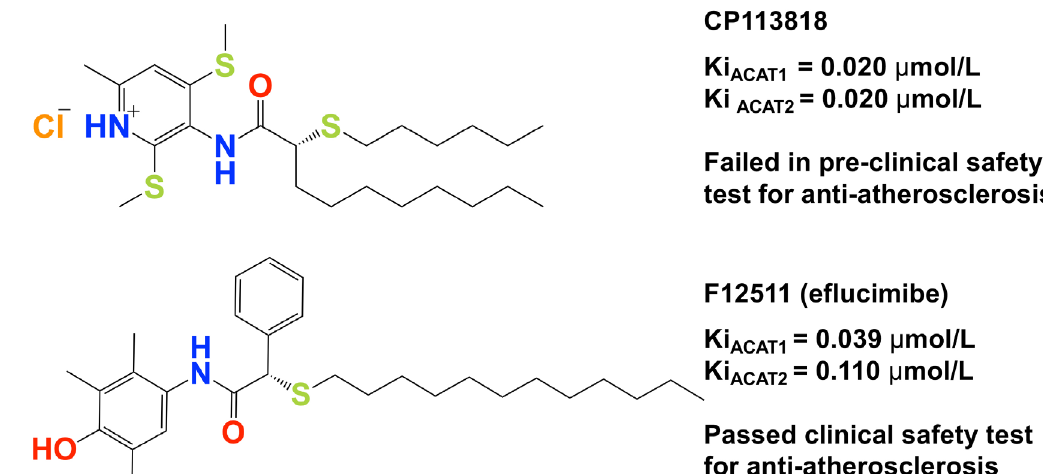
Figure 3. Comparison of 2 high-affinity ACAT inhibitors CP113818 and F12511